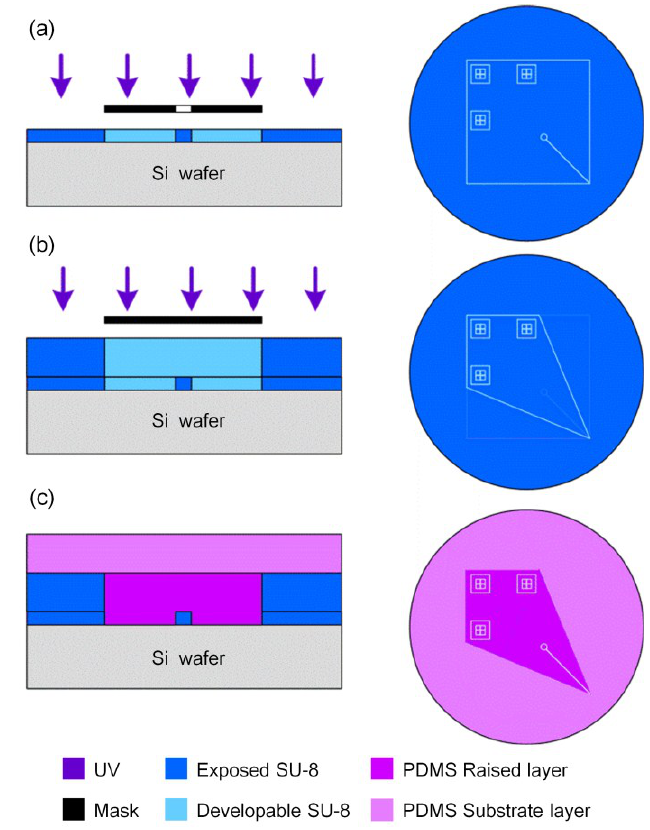
Figure 2. Process schematic. ( a ) the first ca . 30 μm thick SU-8 photoresist layer